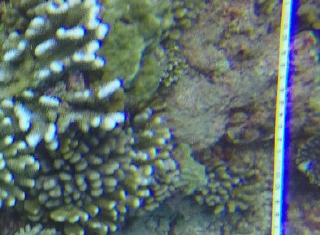
Figure 9. Blue band shift towards image border